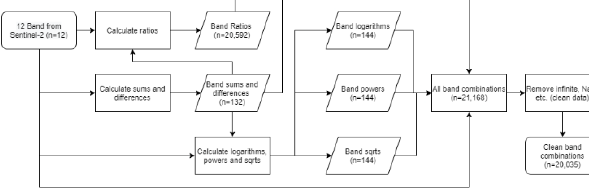
Figure 2 . Methodology workflow for generating new features based from band